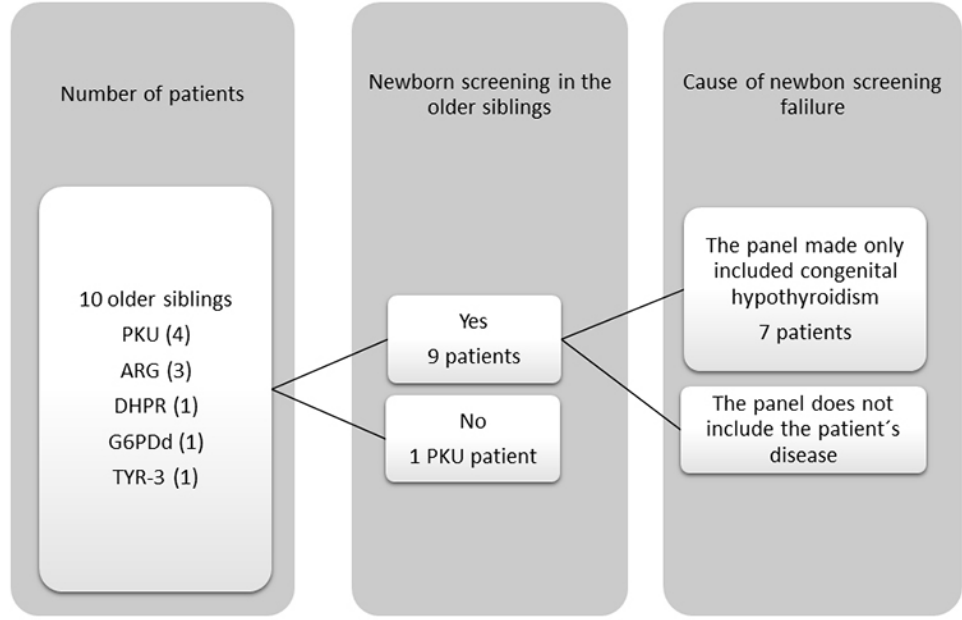
Figure 2. Causes of lack of early detection in the older symptomatic siblings